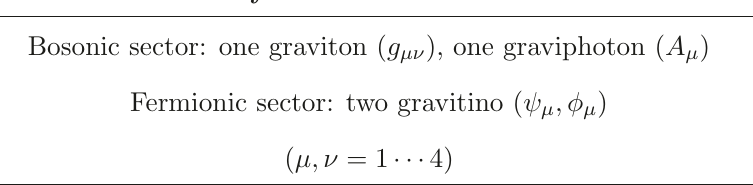
Table 1 . Field content in minimally coupled